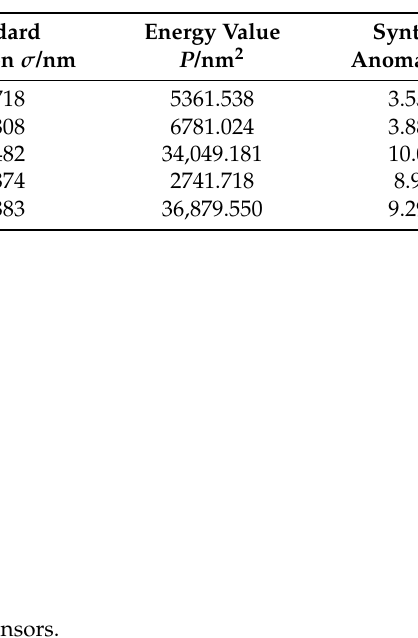
Figure 10. Experiment setup diagram of fault detection instrument for the FBG sensing system on an airplane.